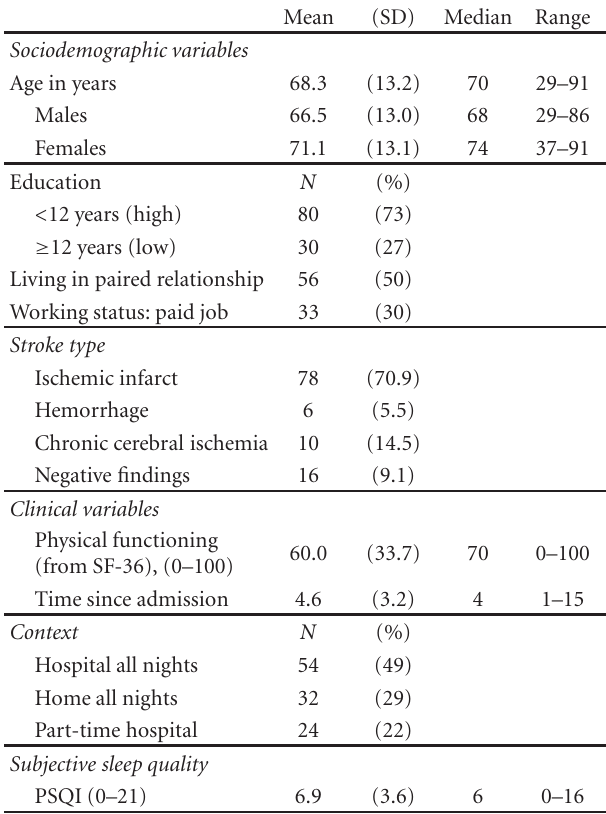
Table 1: Characteristics of the sample ( N =